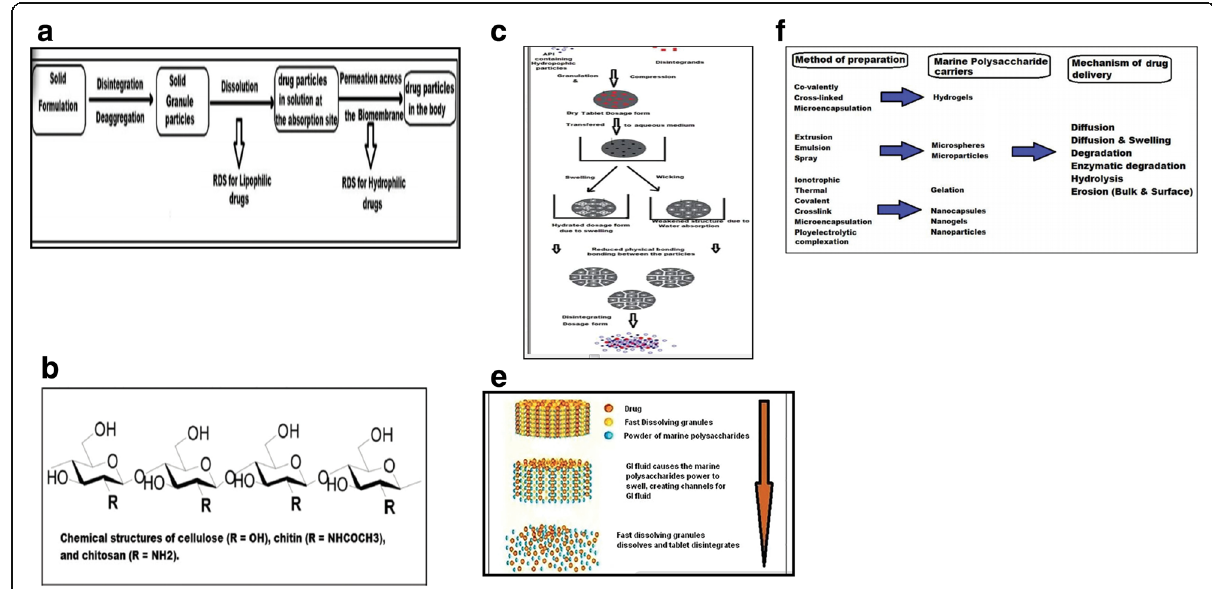
Fig. 4 a The two rate determining steps in the absorption of orally administered dosage. b Structure of cellulose, chitin and chitosan. c Disintegrants facilitating the breakdown of the tablet into granules. e Dissolution enhancer facilitating dissolution for the poor soluble drug. f Illustrating the mechanism of various marine polysaccharide carriers and their method of